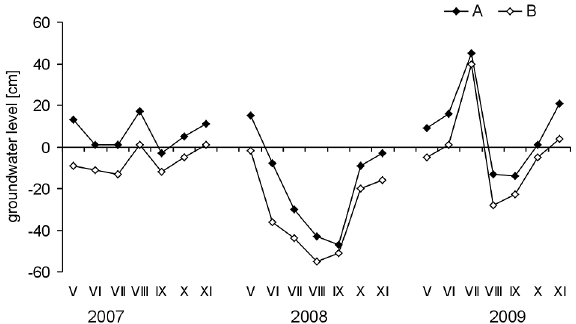
Fig. 3. Changes of groundwater level in near-edge zone (A) and near-bed zone (B) of the Chwiszczej river valley in the years 2007–2009.